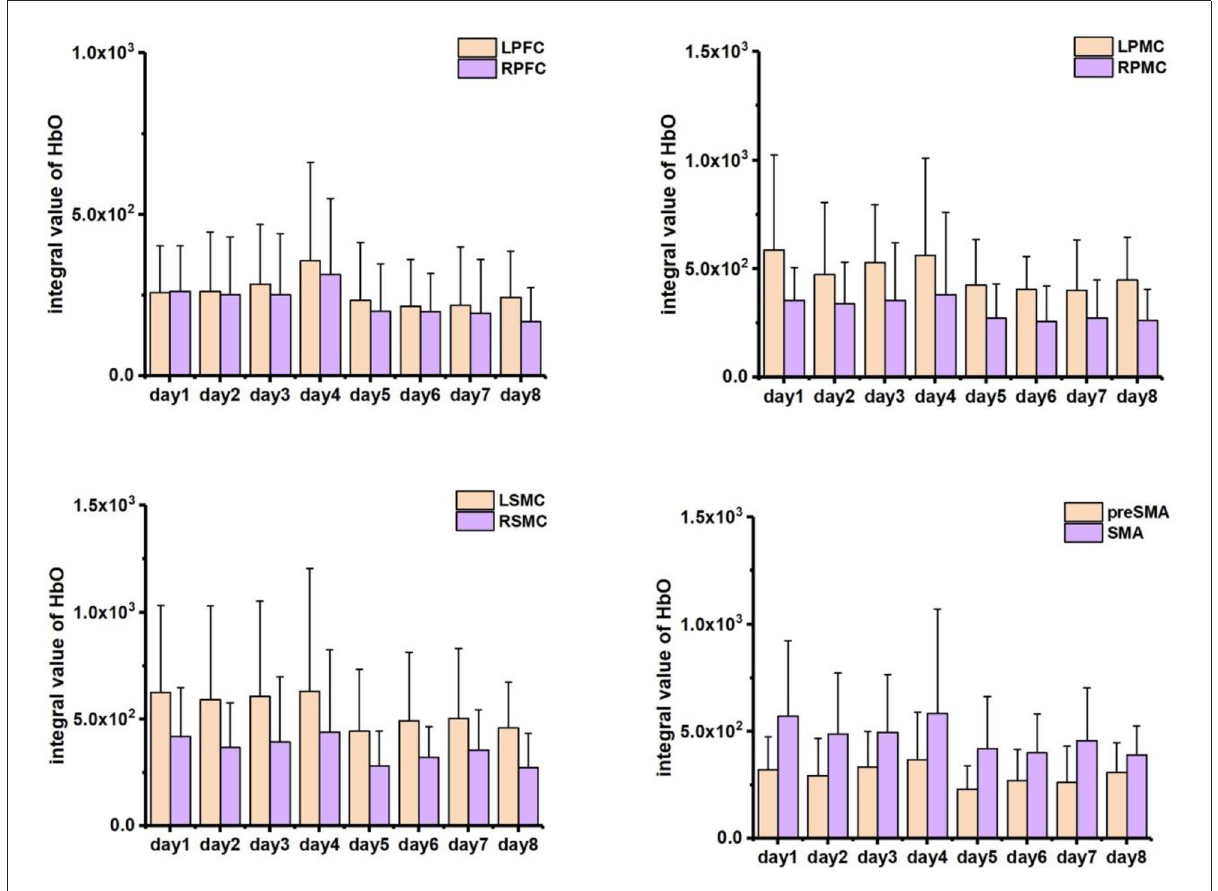
FIGURE7 Averaged integral value of 1 [HbO] activation within ROIs during